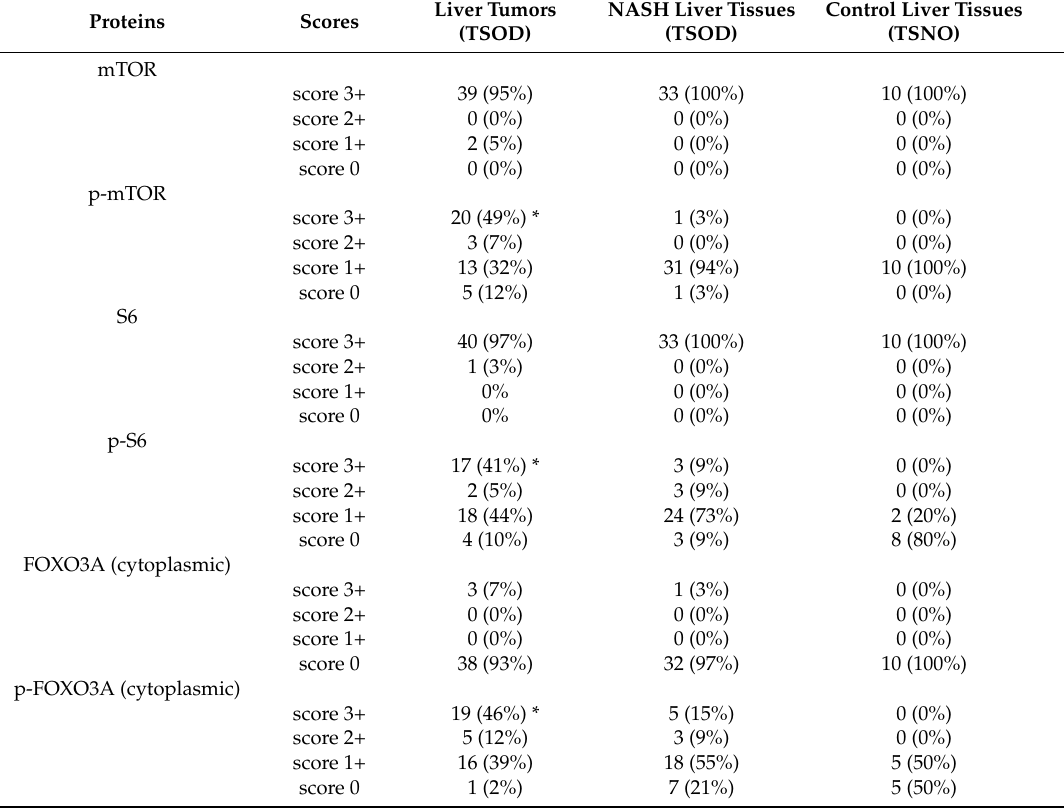
Table 5. Immunohistochemical findings for liver tumors and liver tissues of TSOD and TSNO mice. Proteins Scores